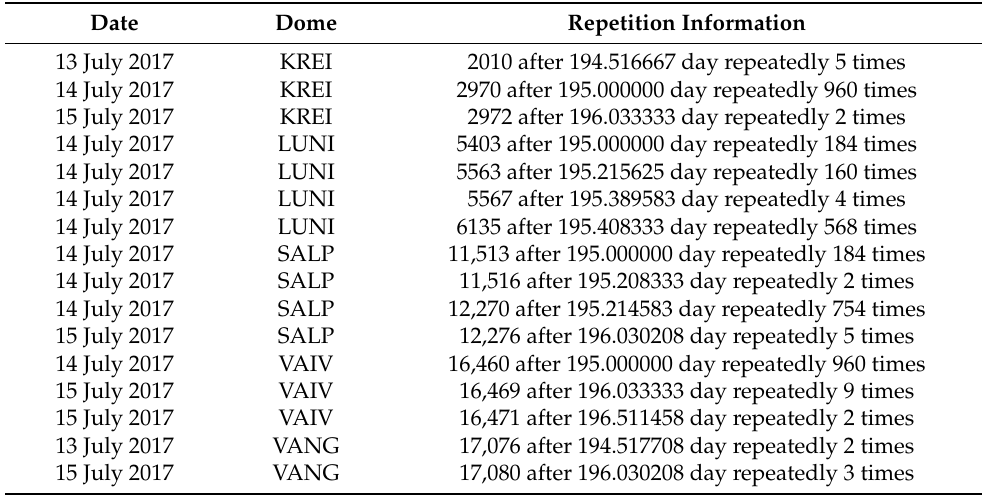
Table 4. Part of the output diagnostics for July